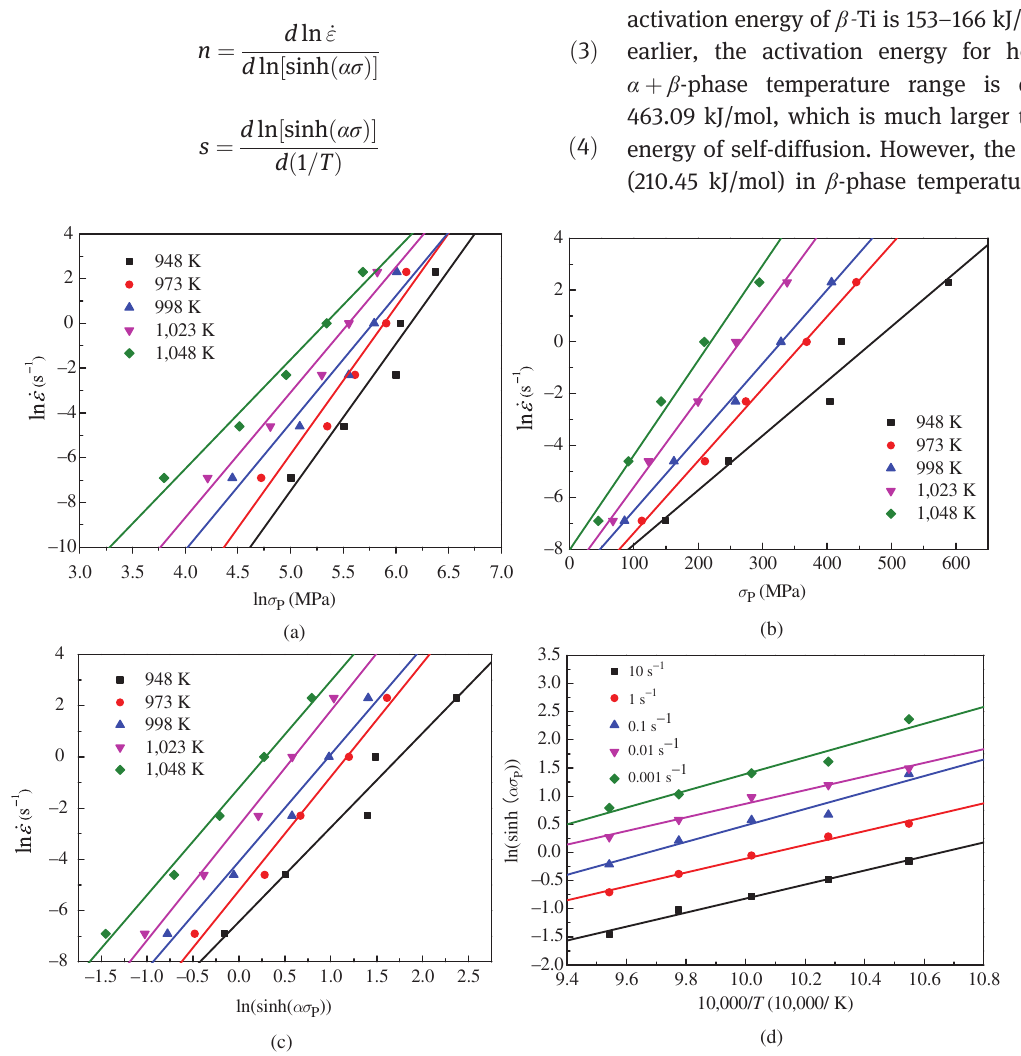
Figure 3 Relationships between (a) ln _ " (cid:5) ln σ P , (b) ln _ " (cid:5) σ P , (c) ln _ " (cid:5) ln ð sinh ð ασ P ÞÞ , (d) ln ð sinh ð ασ P ÞÞ (cid:5) 10 ; 000 = T in α þ β -phase tem- perature